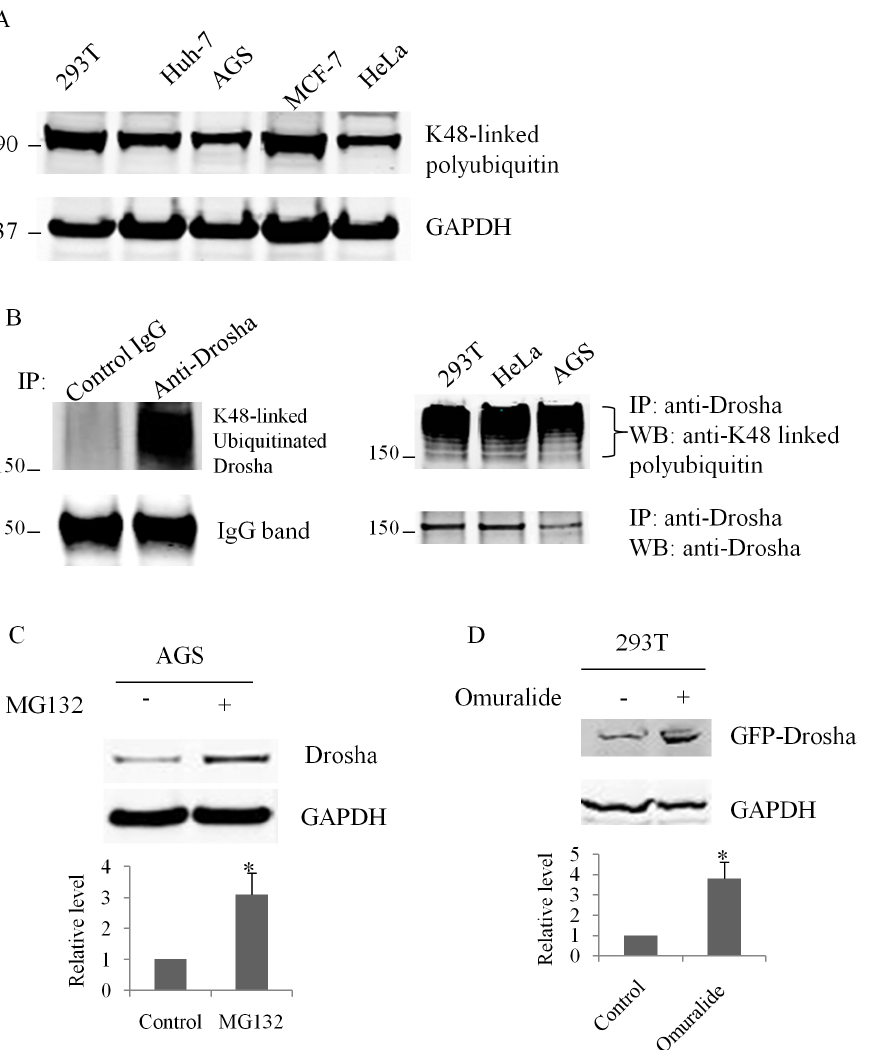
Figure 3. A constitutively active ubiquitin-proteasome pathway degrades Drosha. Whole cell lysates of the indicated cell types were prepared with IP Lysis Buffer (Pierce); 20 m g protein aliquots were used for western blots. All experiments were repeated three times with similar results (p , 0.05 by Student’s t-test). ( A ) Abundant polyubiquitination was observed in multiple cell types using lysine 48-linkage specific polyubiquitin antibody. ( B ) Drosha is ubiquitinated in various cell types including HEK293T, HeLa and AGS. Left panel: HEK293T lysates were immunoprecipitated with control IgG or Rabbit Polyclonal Antibody to Drosha respectively. Right panel: Cell lysates were immunoprecipitated respectively with Rabbit Polyclonal Antibody to Drosha. The immunoprecipitates were resolved by SDS-PAGE and blotted with lysine 48-linkage specific polyubiquitin antibody. The same membrane was reblotted with Drosha Rabbit mAb. ( C ) Inhibition of the ubiquitin-proteasome pathway with MG132 (10 m M) increases endogenous Drosha protein level in AGS cells. GAPDH was used as a loading control. ( D ) Proteasomal inhibition increases exogenous GFP-Drosha expression level. HEK293T cells were transfected with GFP-Drosha. Twenty-four hours post-transfection, the cells were treated with 1 m M Clasto-Lactacystin- b -lactone (Omuralide) overnight. GFP-Drosha protein level was increased 3-fold following treatment. 390 amino acids or C-terminal 524 amino acids (Figure 4A). We found that the N-terminal truncated mutant expressed at higher levels ( , 6-fold) than the C-terminal truncated mutant (Figure 4B), suggesting that the N-terminus with its 13 lysines harbored a major regulatory domain (57 lysines in C-terminus). We next made a series of expression constructs by progressively shortening the length of N-terminal Drosha (Figure 4C). Our results revealed that the shortest construct (984aa) with the fewest lysines (n= 57) expressed at , 6-fold higher levels compared to the full length parental construct (Figure 4D), indicating that the N-terminus of Drosha is the main part for ubiquitination.